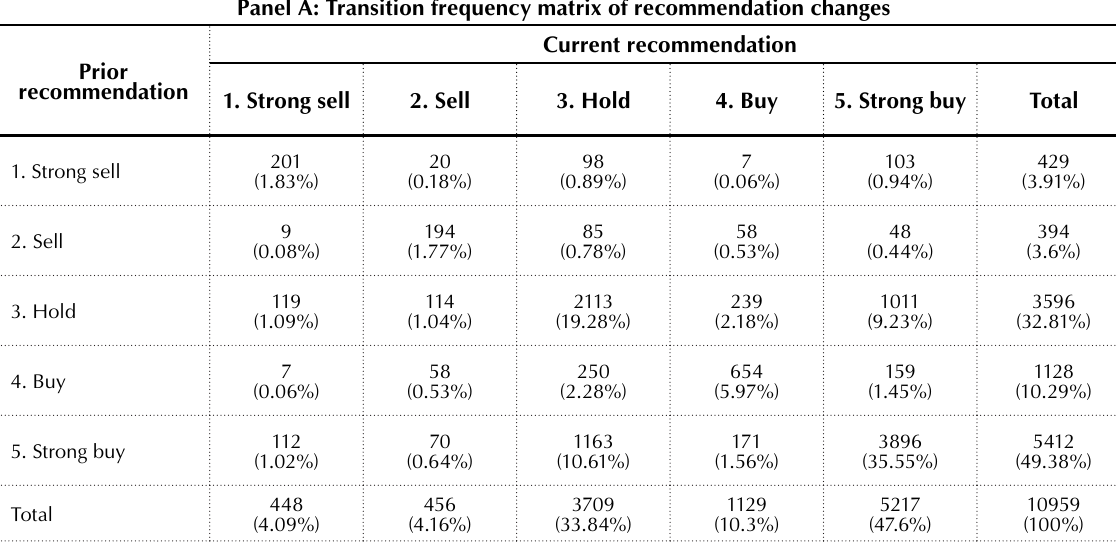
Table 1. Features of recommendation changes Panel A: Transition frequency matrix of recommendation changes Prior